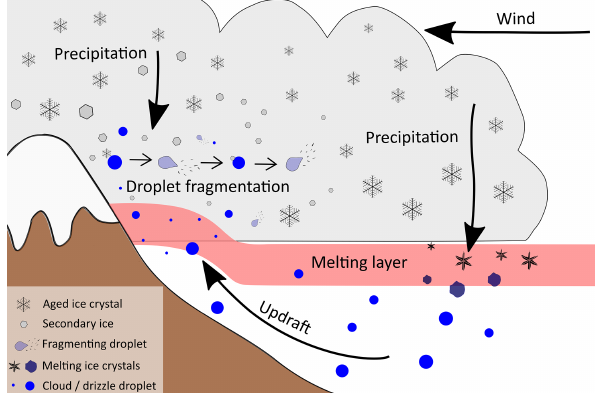
Figure 7. Schematic of the recirculation process, which was intro- duced by Korolev et al. (2020) and adapted for an updraft created by a mountain slope. Aged ice crystals sediment from the cloud and turn into drizzle-sized drops when they fall through the melting layer. These drops are reintroduced into the cloud by wind forced up the mountain slope (updraft), where they freeze when they col- lide with aged ice crystals and fragment upon freezing. The small fragments grow into plates due to the environmental conditions ( T > − 3 ◦ C) and may hit other droplets, which again freeze and possibly